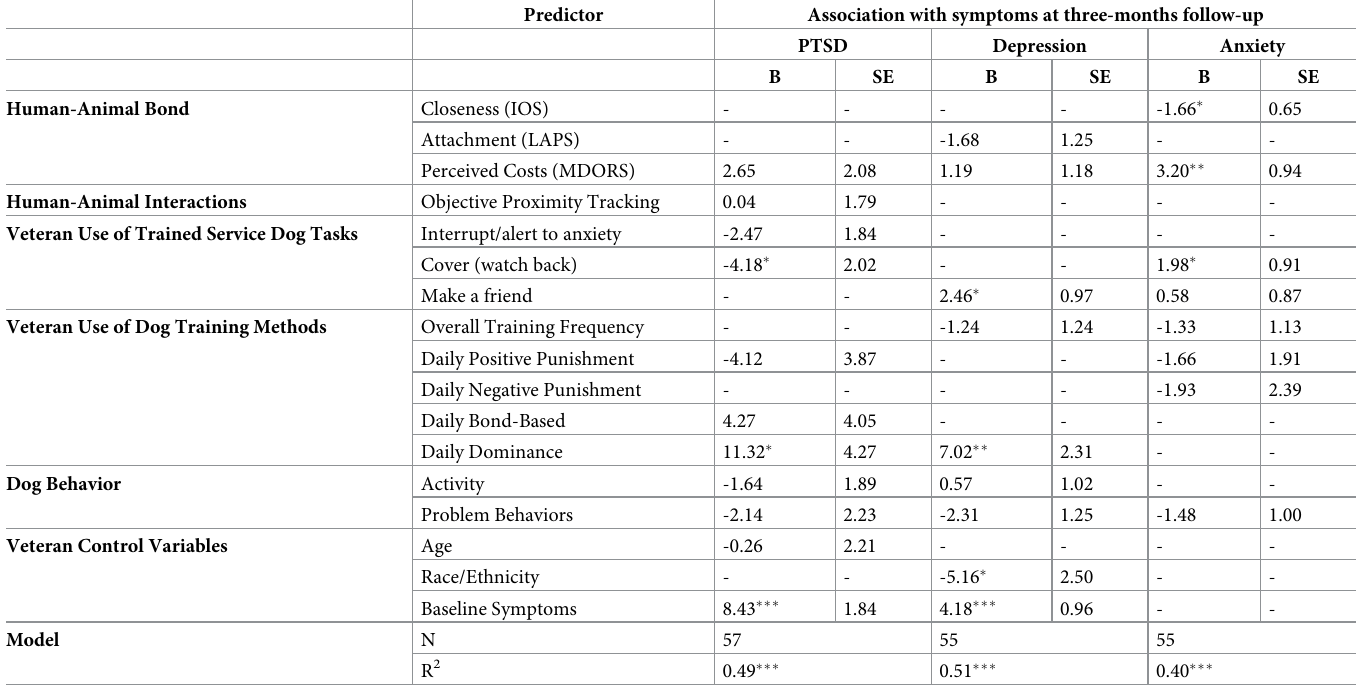
Table 7. Regression outcomes for Aim 3 (identifying mechanisms), after variable selection by elastic